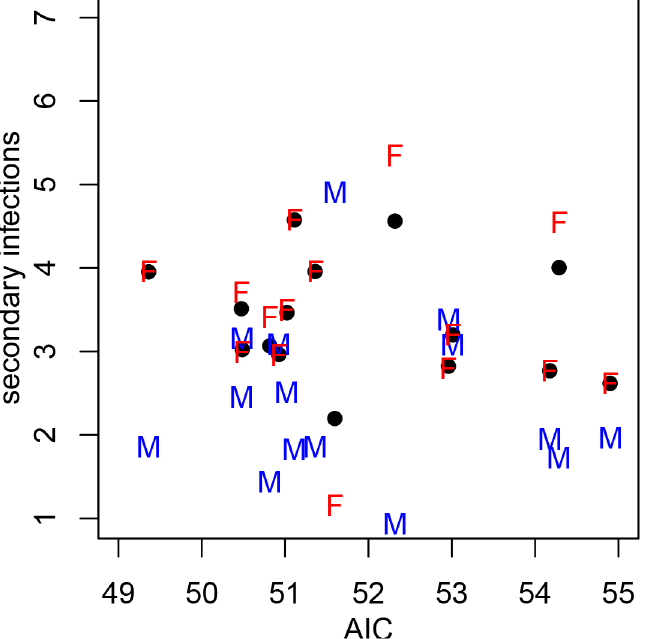
Fig 2. The number of secondary infections per one infected individual R 0 (black circles), per one infected male q G 1 (blue M) and per one infected female q G 2 (red F) for buck:doe ratio 1:3. Most models predict that infected females create almost twice as many secondary infections than infected females. See Table 5 and Eq 10 for details.